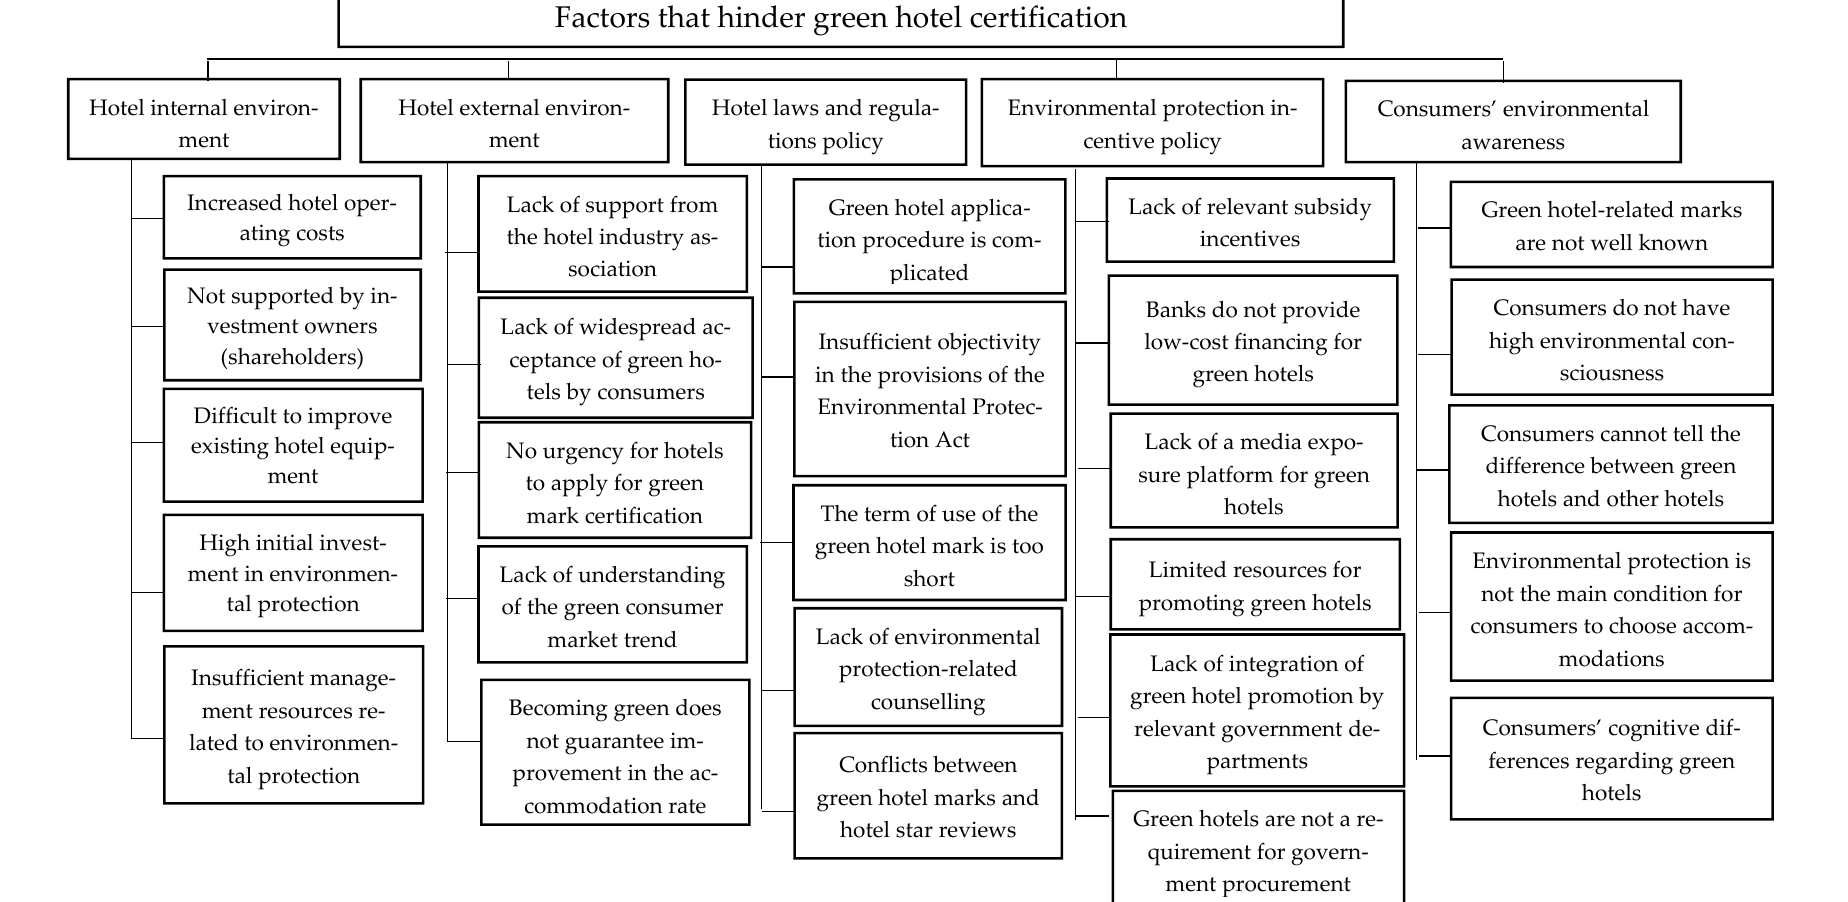
Figure 2. The hierarchical structure of hindering factors of green hotel certification.